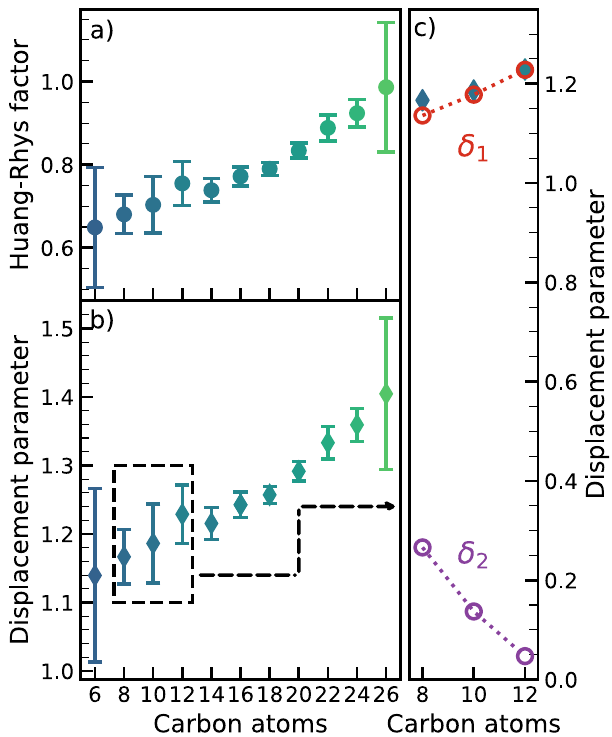
Fig. 4 | Huang – Rhys and effective displacement parameters of hydrogen- capped polyynes. a Huang – Rhys factors S and b effective nondimensional dis- placement parameter δ eff of H-capped polyynes with increasing length extracted from UV-Vis absorption spectra (see Supplementary Fig. 5). c Effective nondimen- sionaldisplacementparameter δ eff (blueishdiamonds)calculated fromHRfactors (see Eq. (1)) extracted from experimental UV-Vis absorption spectraof C 8 , C 10 , and C 12 . The displacement parameters for the α ( δ 1 , red dots) and β ( δ 2 , purple dots) modesofC 8 ,C 10 ,andC 12 ,calculatedfromUVRRandUV-Visabsorptionspectrawith the method explained in Supplementary Discussion, are also reported for com- parison. The errorbars of panels a and b represents the error of the fi t model used to deconvolve the UV-Vis absorption